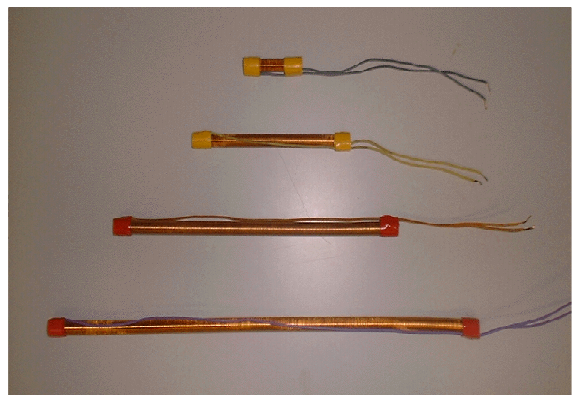
Figure 3. Different developed coils.